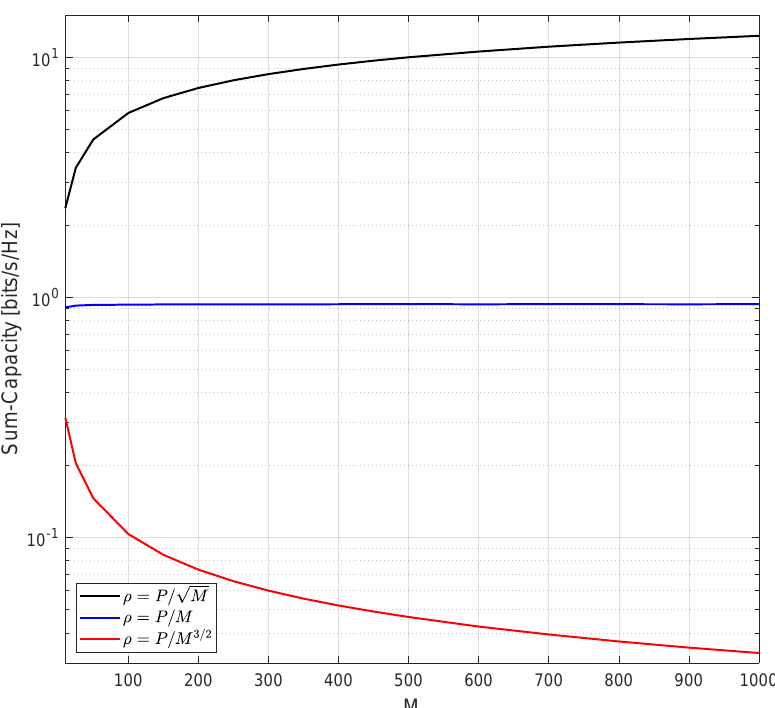
Figure 5. Demonstration of the power scaling law for different α values.